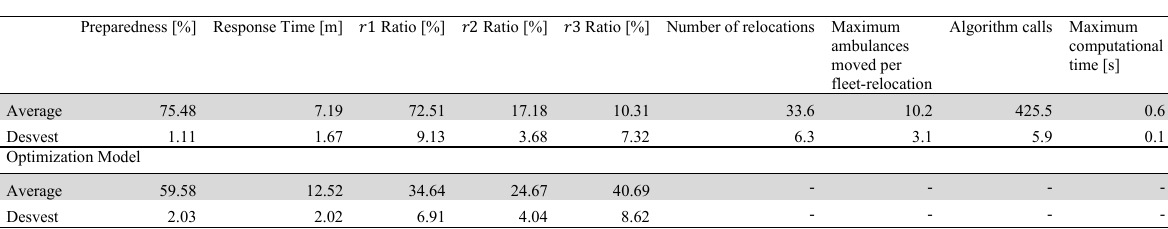
Fig. 3. Simulated Evolution of the System Preparedness of Five Independent Replications Results of 200 Independent Simulation Replications Real-Time Optimization Algorithm